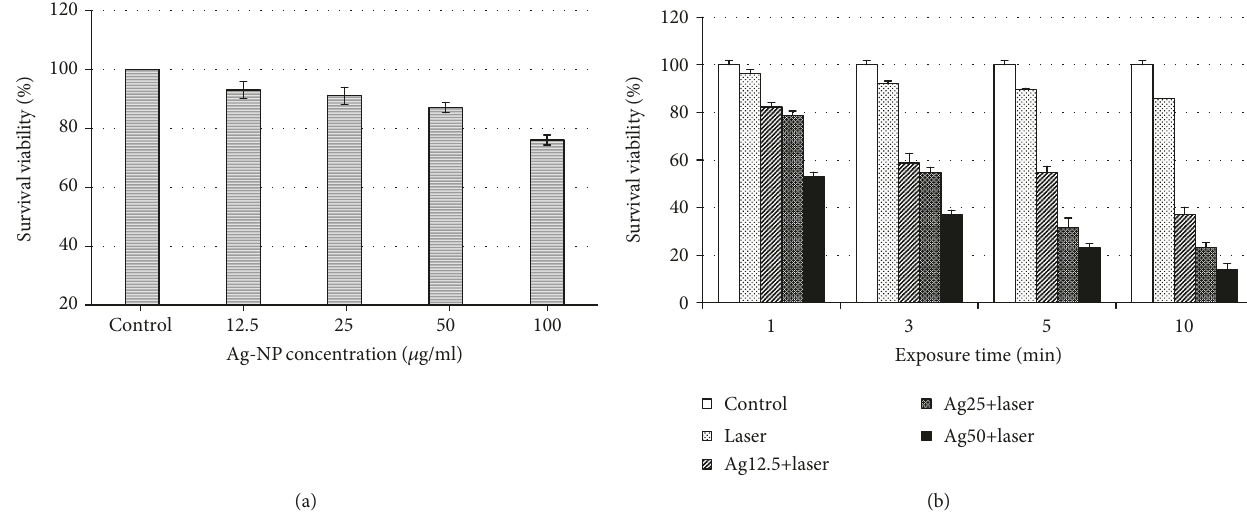
Figure 4: (a) E ff ect of Ag-NPs on the survival of E. coli for di ff erent concentrations (12.5, 25, 50, and 100 μ g/ml) under normal light condition. (b) E ff ect of laser irradiation at 410nm and photoirradiation of Ag-NPs on the survival of E. coli for di ff erent exposure times (1, 3, 5, and 10min) and concentrations of Ag-NPs (12.5, 25, and 50 μ